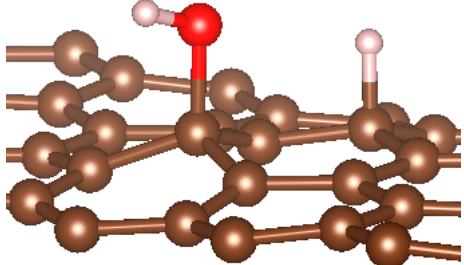
Figure 5. sp 3 hybridization of the adsorption site for graphene material.